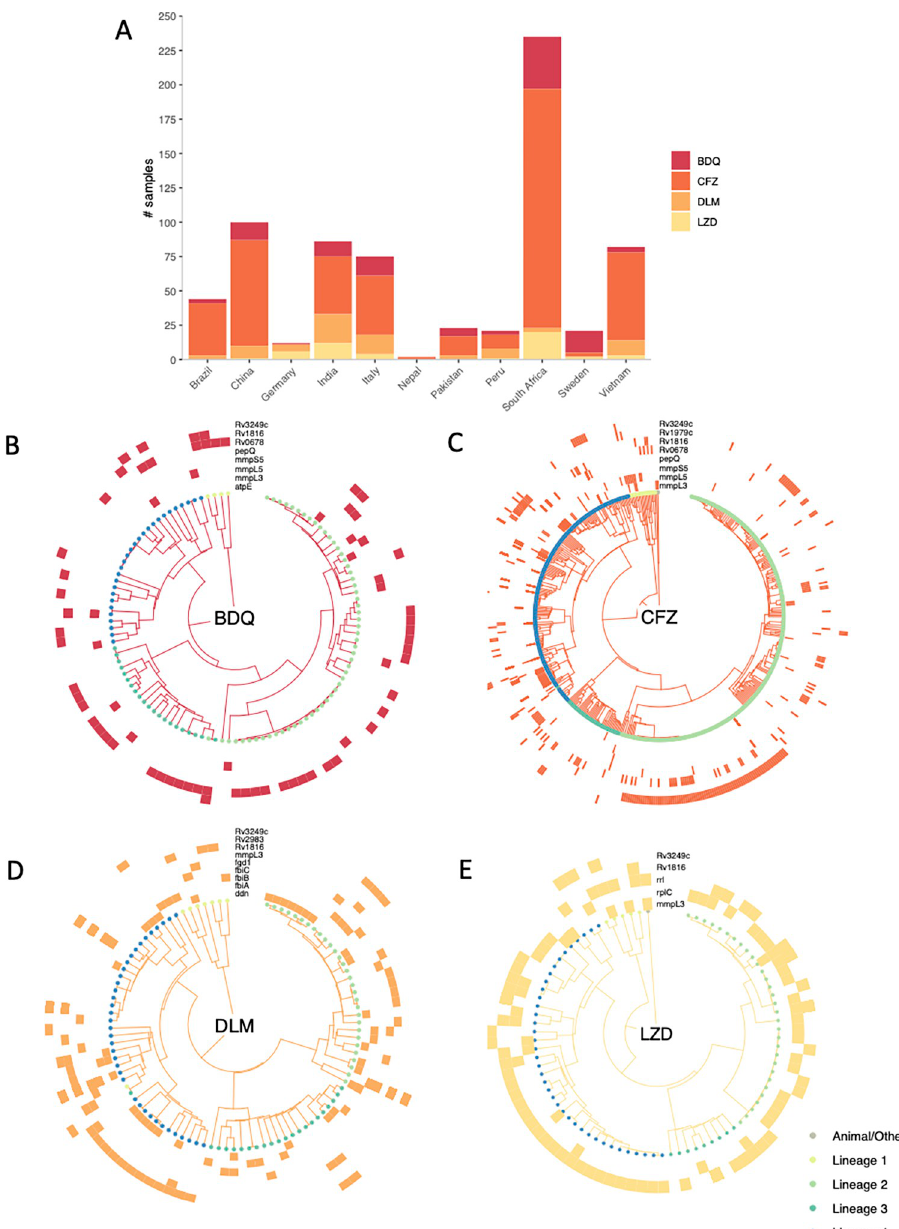
Fig 5. Resistance to bedaquiline, clofazimine, delamanid, and linezolid among Mycobacterium tuberculosis compendium isolates. (A) The prevalence (within these data) of resistance to BDQ, CFZ, DLM, and LZD per country or origin or collection site. Phylotrees are shown for isolates phenotypically resistant to (B) BDQ, (C) CFZ, (D) DLM, and (E) LZD. Tip point colours denote lineage. Each outer track represents a gene thought to be associated with resistance and coloured blocks denote the presence of a nonsynonymous mutation in the relevant gene for a given isolate. Mutations in these genes that are either associated with sensitivity or present in > 5% of the collection of isolates as a whole were ignored. BDQ, bedaquiline; CFZ, clofazimine; DLM, delamanid; LZD,